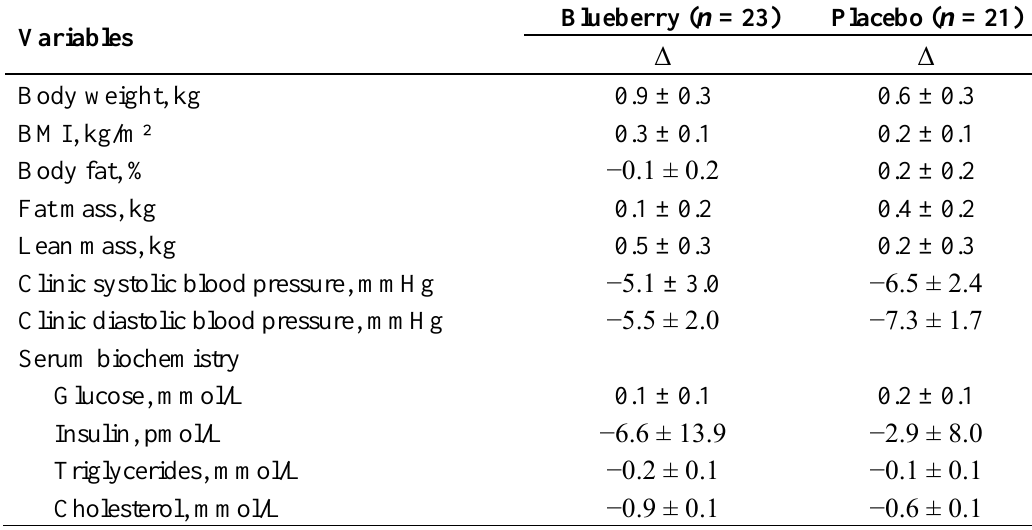
Table 3. Changes in body weight, body composition, blood pressure and glucose, insulin and lipid concentrations of participants with metabolic